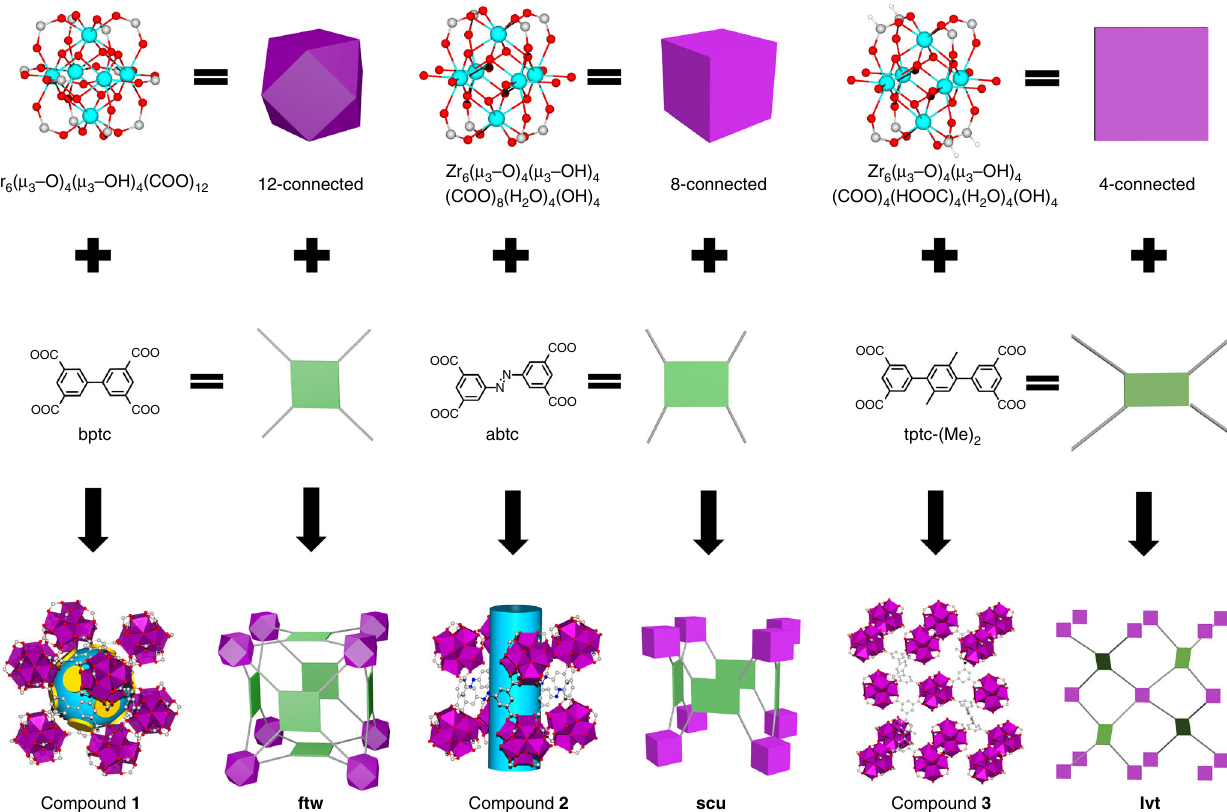
Fig. 1 Structure analysis of compounds 1 – 3 . Compounds 1 , 2 , and 3 are built on 12-, 8-, and 4-connected Zr 6 clusters, linked by tetratopic organic ligands bptc, abtc, and tptc-(Me) 2 , forming ftw , scu , and lvt type structures,